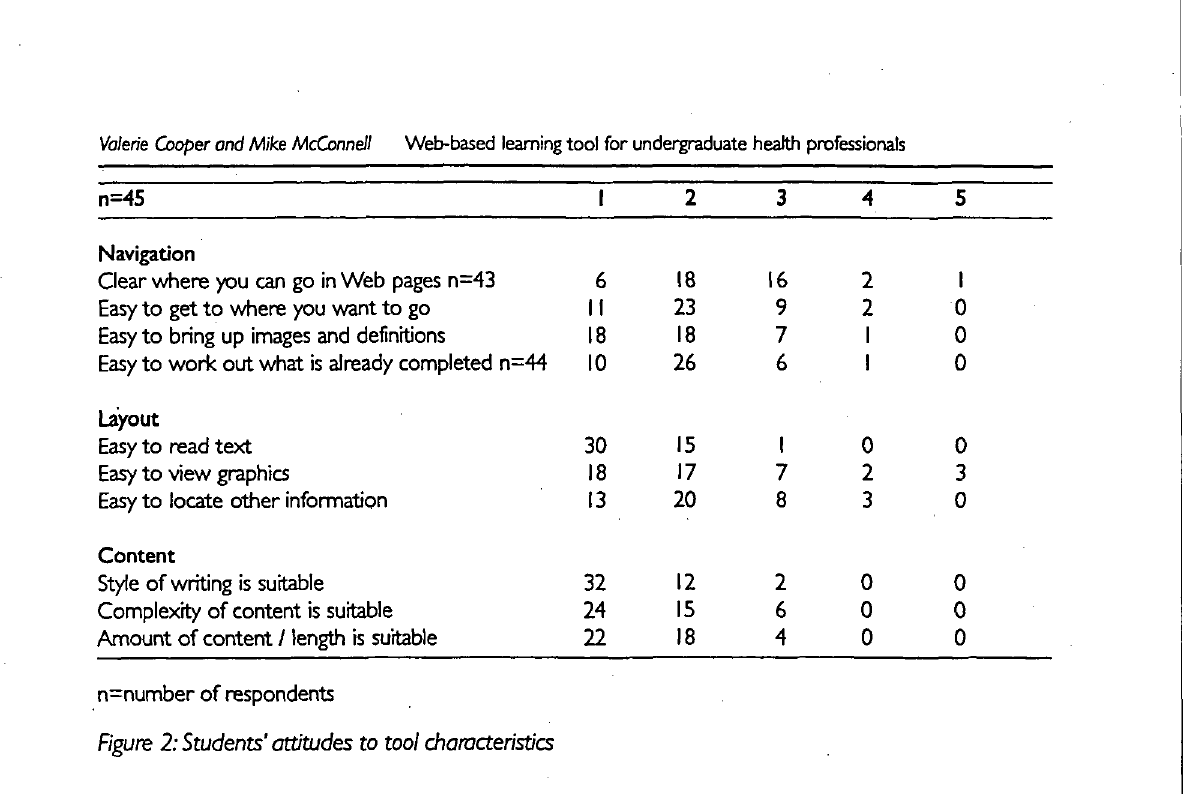
Figure 2: Students'attitudes to tool